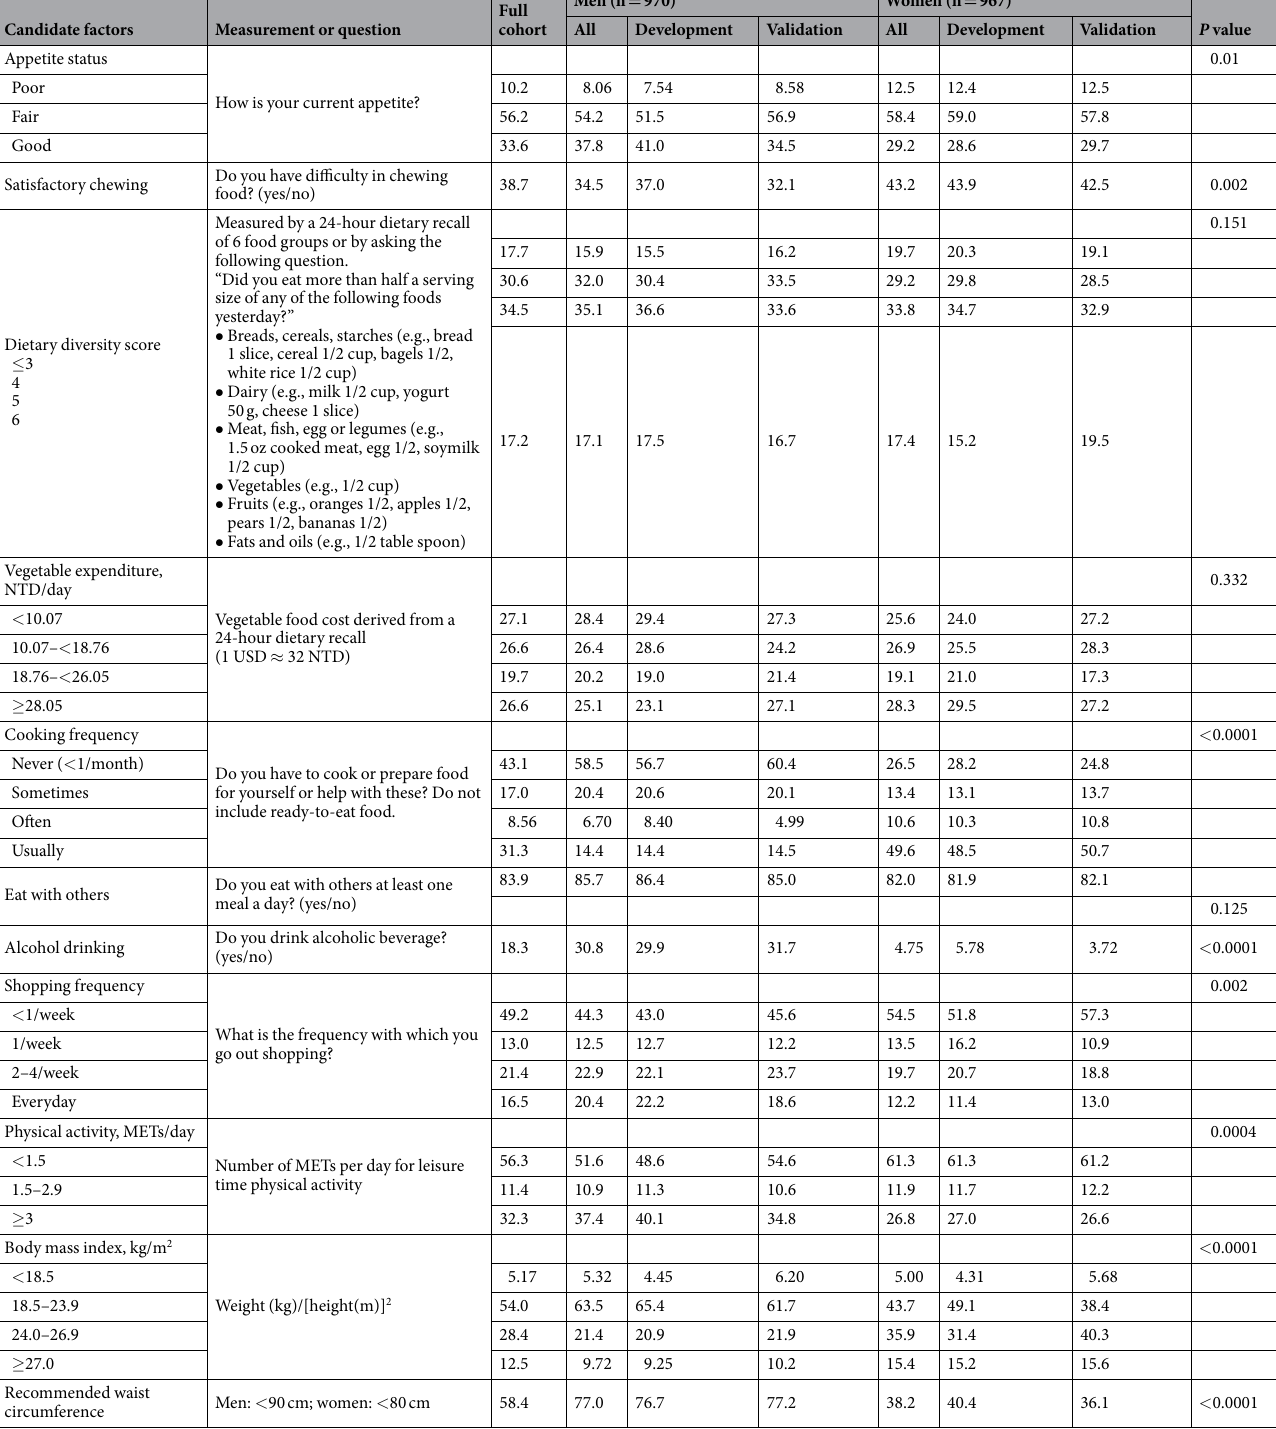
Table 1. Measurement and distribution (%) of each candidate factor by gender. USD, US Dollar; NTD, Taiwan New Dollar; METs, metabolic